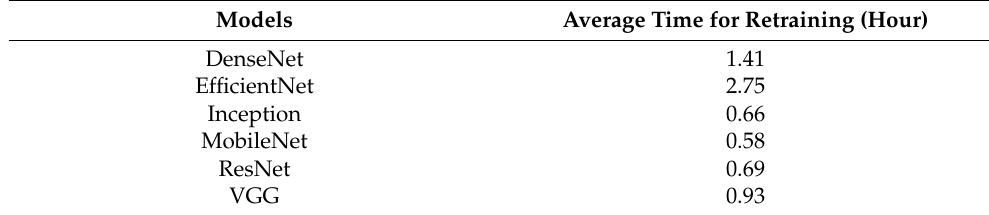
Table 4. Average elapsed time for retraining each